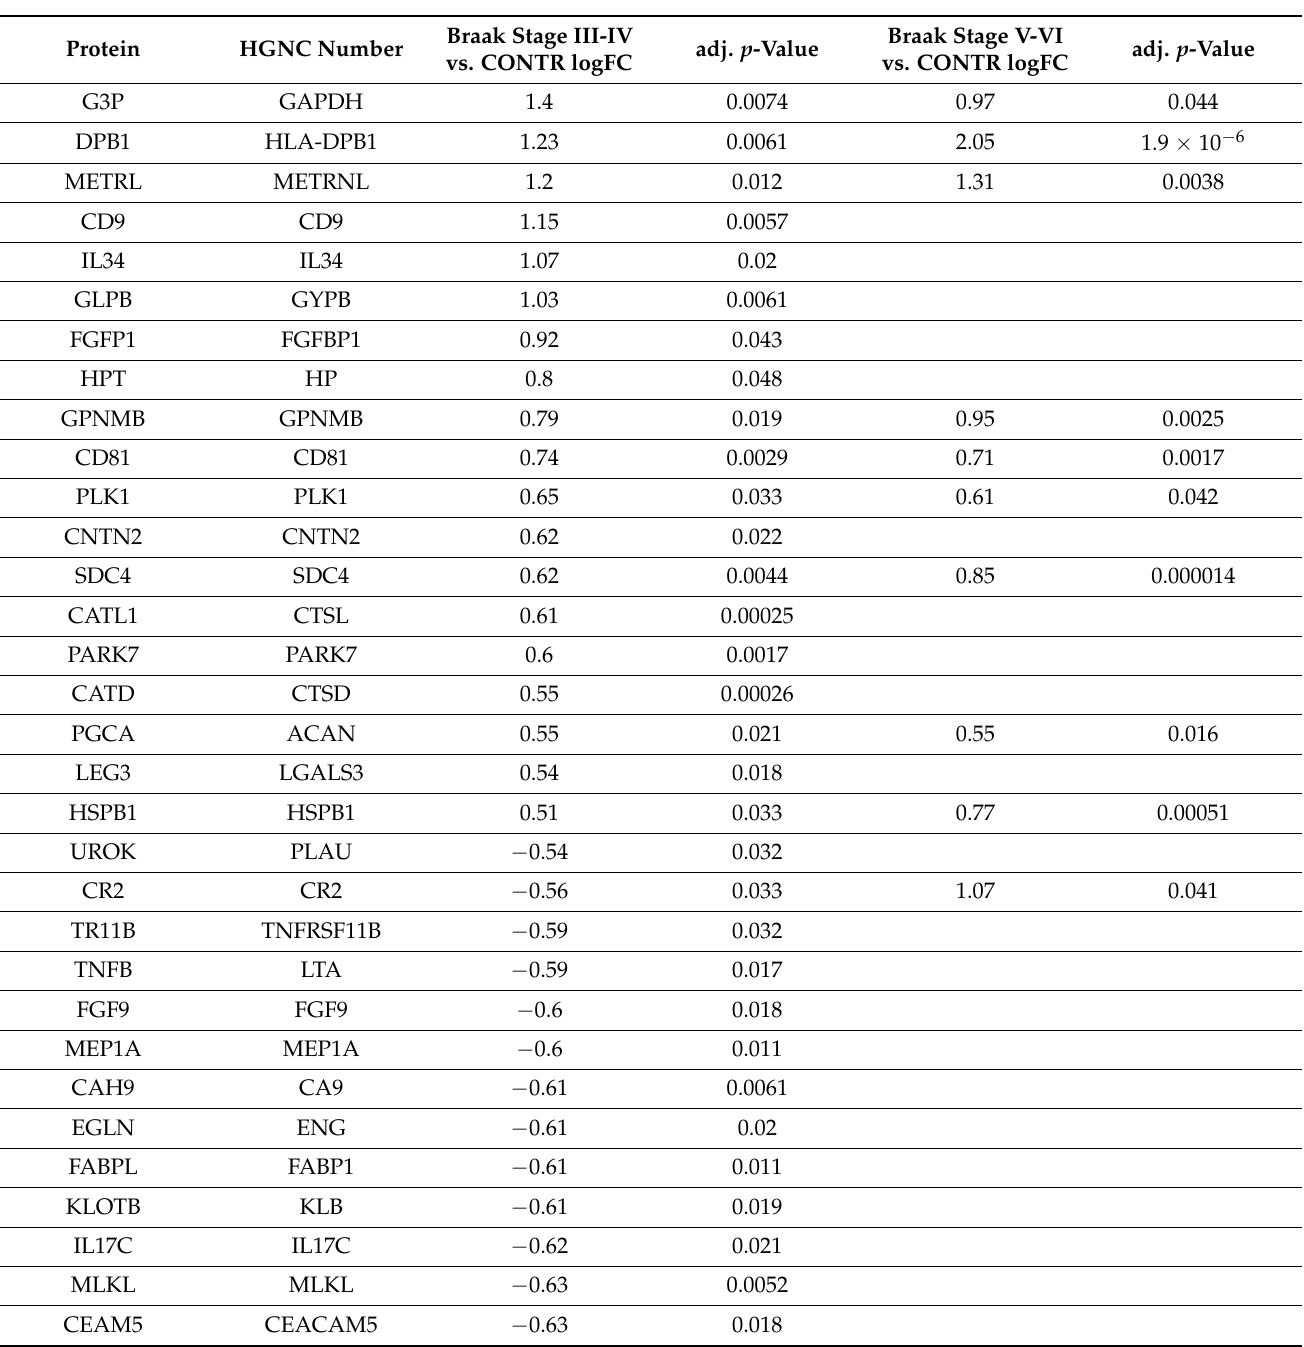
Table 3. DE-proteins in Braak stage III-IV and Braak stage V-VI compared to controls (Braak stage I-II). Fold changes (LogFC), standard deviation, and adj. p -values ≤ 0.05 are